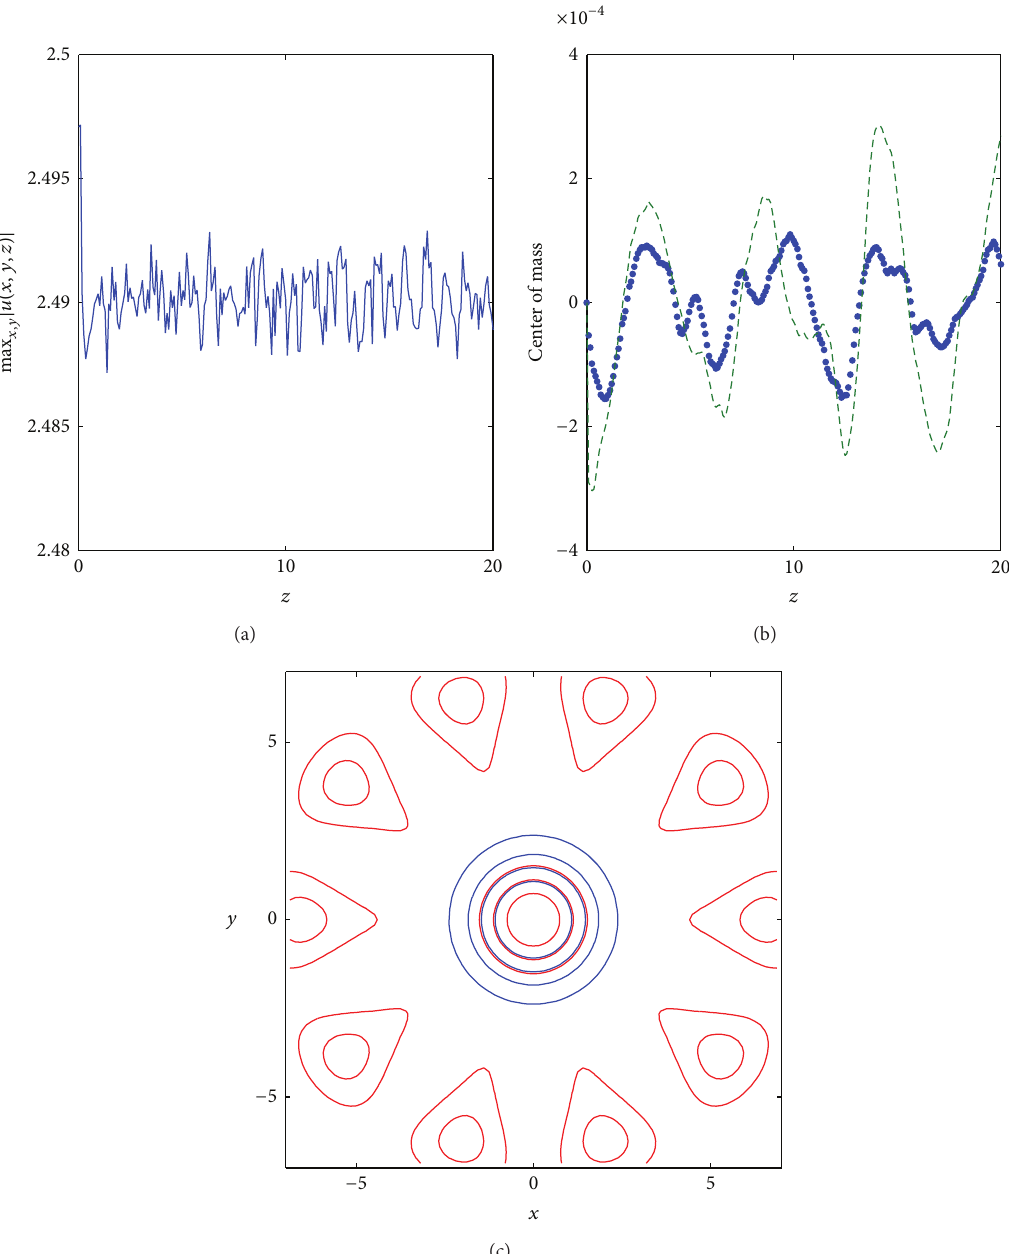
Figure 18: Nonlinear evolution of the lattice soliton corresponding to the second renormalization factor situated at the Penrose potential with 𝜇 = 1.5 for the self-focusing cubic and the self-defocusing quintic model. (a) Peak amplitude of the lattice soliton as a function of the propagation distance. The initial condition is taken as the lattice soliton corresponding to the first renormalization factor with a 0.01 noise in the amplitude and phase. (b) Center of mass evolution in 𝑥 and 𝑦 coordinates. (c) Cross section along the diagonal axis of the fundamental soliton superimposed on the Penrose potential after the propagation ( 𝑧 = 20